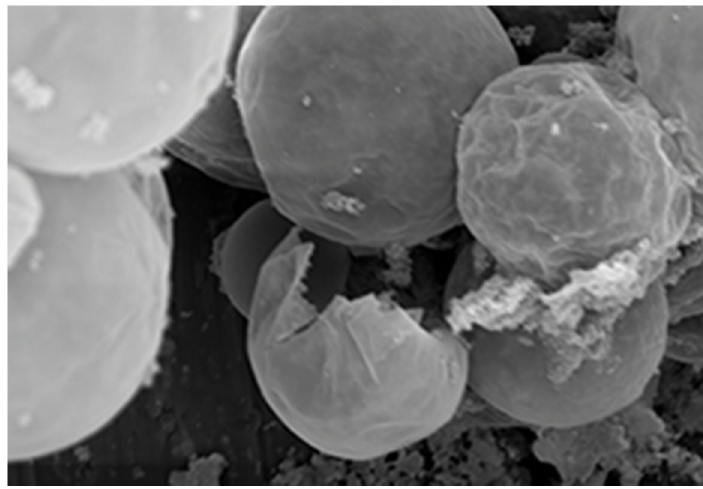
Figure 1. Poly-Pore hollow bead sorption material, unloaded (magnification 500 x). doi: